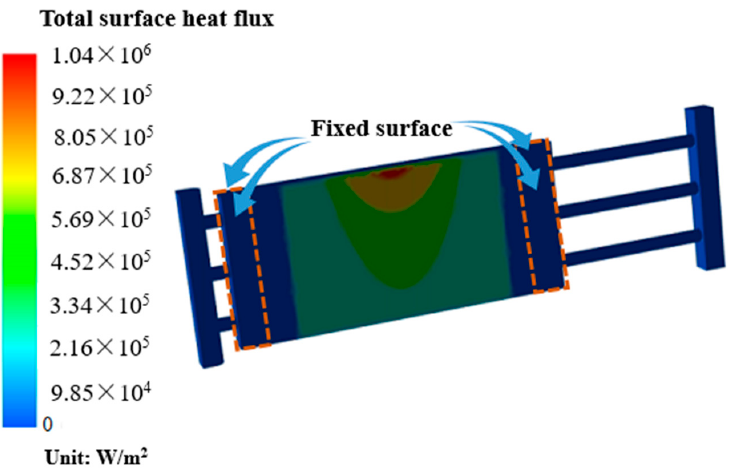
Figure 6. The heat flux profile of the entrance collimator. The maximum temperature, flow velocity and pressure drop of the optimal design scheme for the collimator at the entrance on the above working conditions and parameters are shown in Figures 9 and 10. In Figure 9, the maximum temperature of the heat-loaded surface increases rapidly in the first 20 s, and then the rate slows and becomes nearly steady. The maximum temperature is nearly 335 K, which means at the corresponding